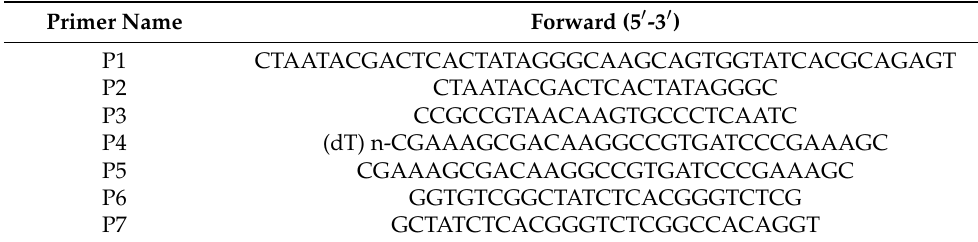
Table 2. The primer messages of RACE